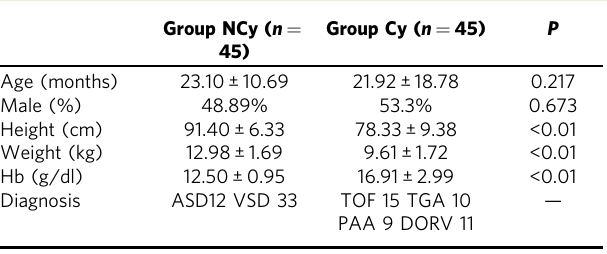
ASD atrial septal defect, VSD ventricular septal defect, TOF tetralogy of fallot, TGA transposition of the great arteries, PAA pulmonary artery atresia, DORV double outlet right ventricle